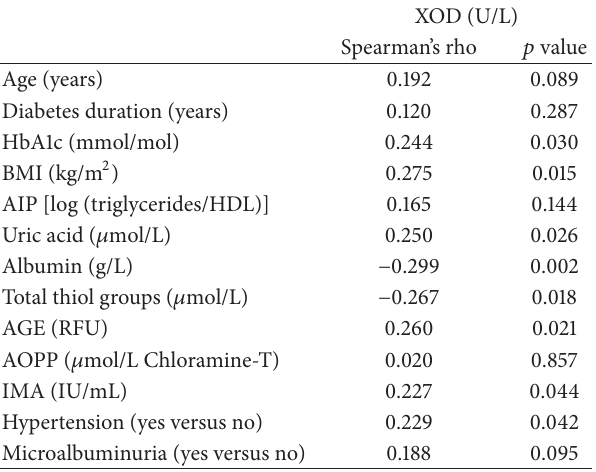
Table 3: Relationships between serum XOD activity and various clinical and biochemical variables in type 2 diabetes